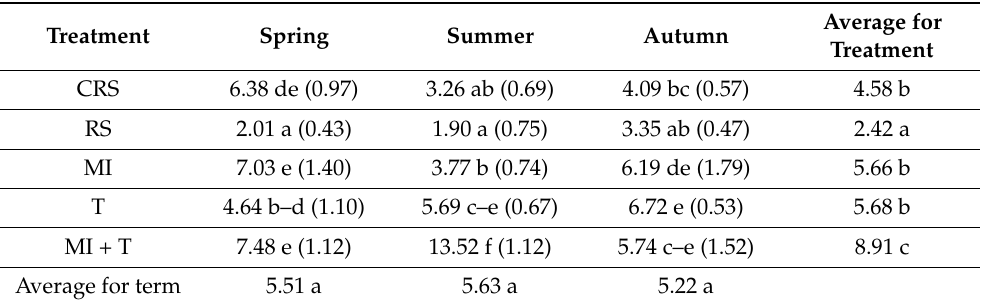
Table 3. Protease activity in the soil (mg of tyrosine h − 1 kg − 1 dm) in the year 2015–2016 (CRS = crop rotation soil; RS = replanted soil; MI = mycorrhizal inoculum; T = Trichoderma ; MI + T = mycorrhizal inoculum + Trichoderma ).